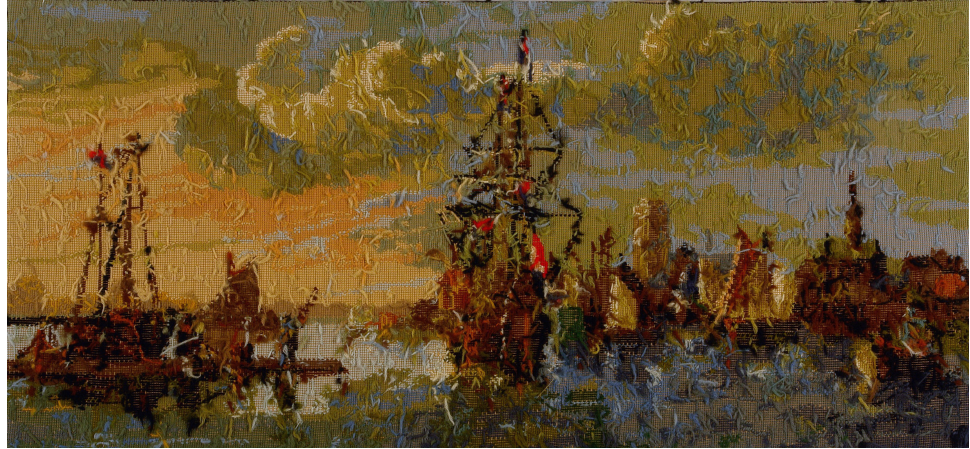
Figure 5: Rob Scholte: View of Amsterdam